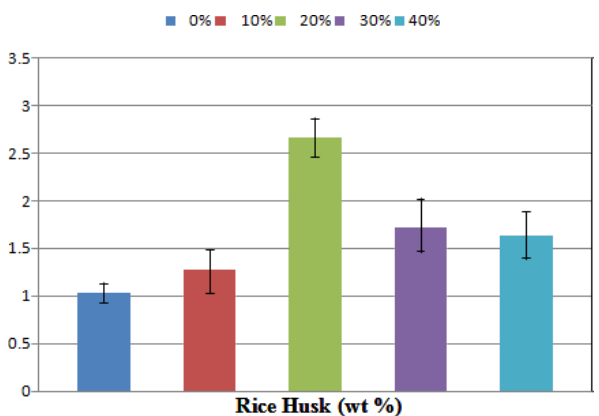
Figure 3: Fracture toughness for different filler